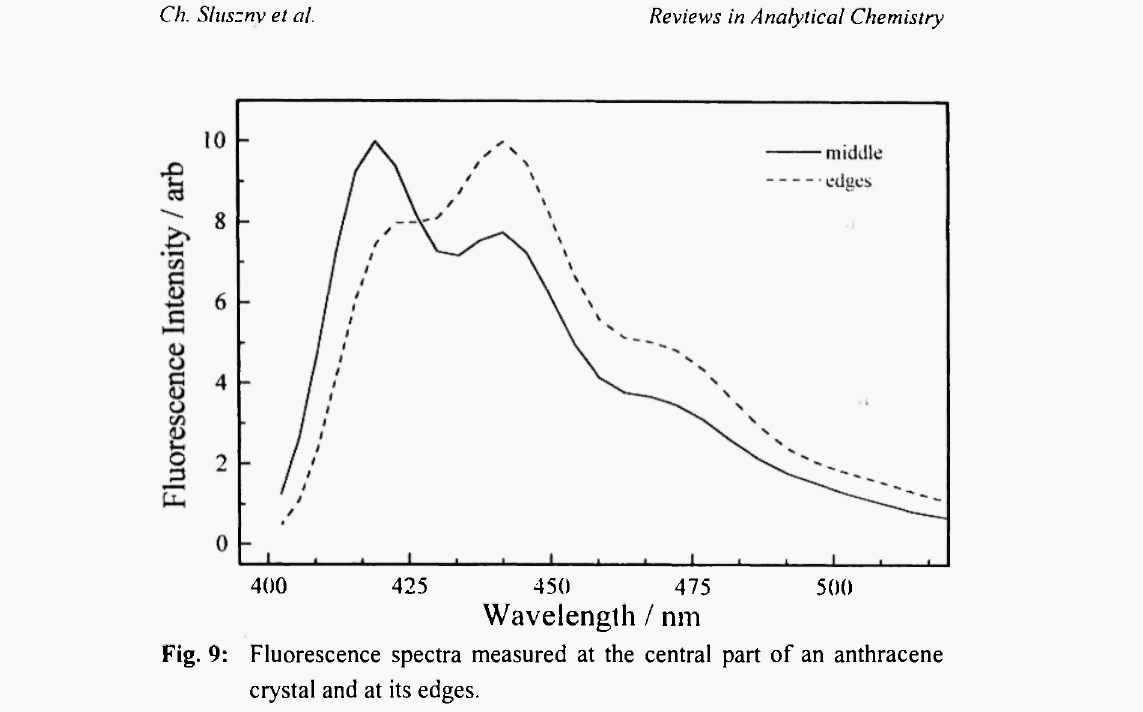
Fig. 9: Fluorescence spectra measured at the central part of an anthracene crystal and at its